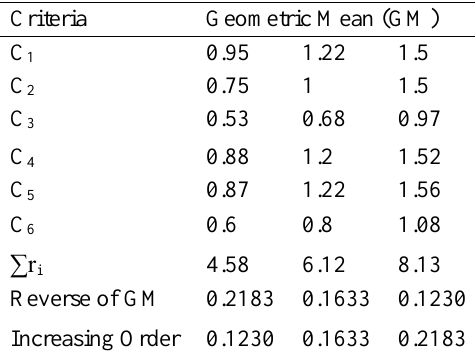
Table 3. Calculation of geometric mean.